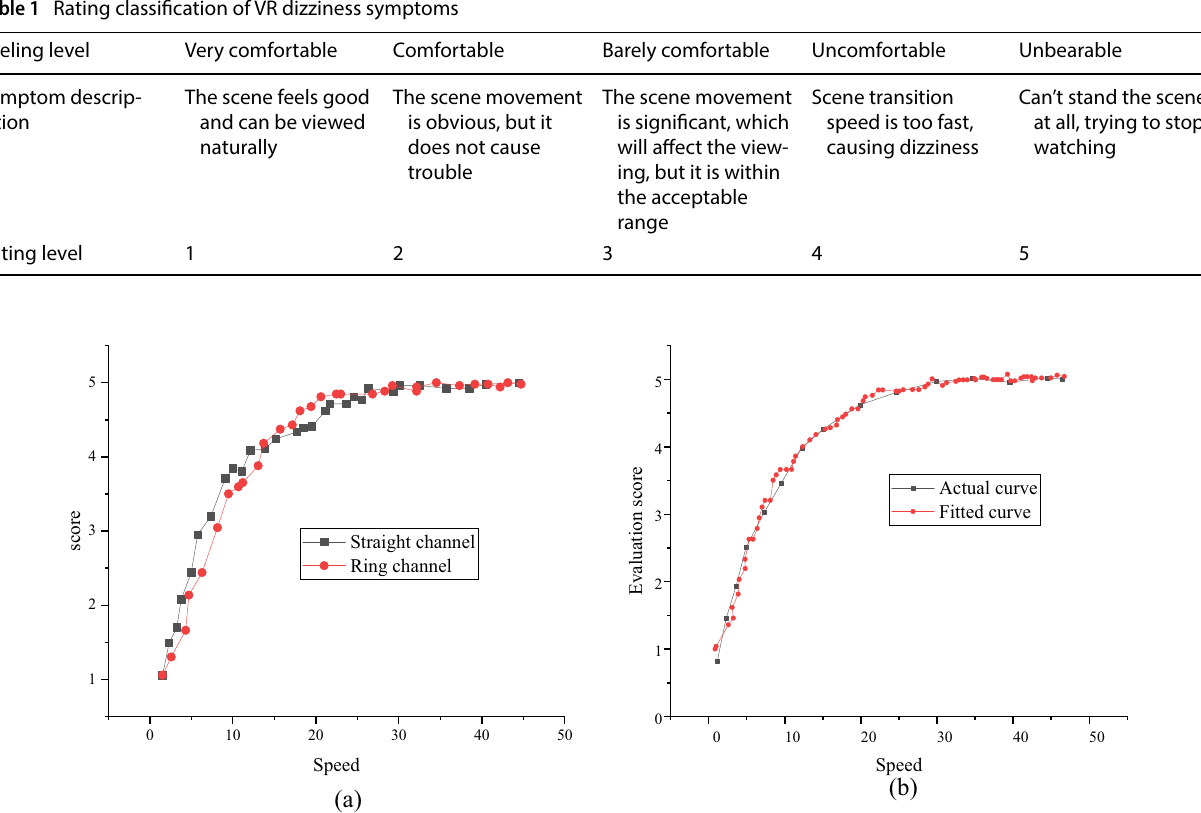
Table 1 Rating classification of VR dizziness symptoms